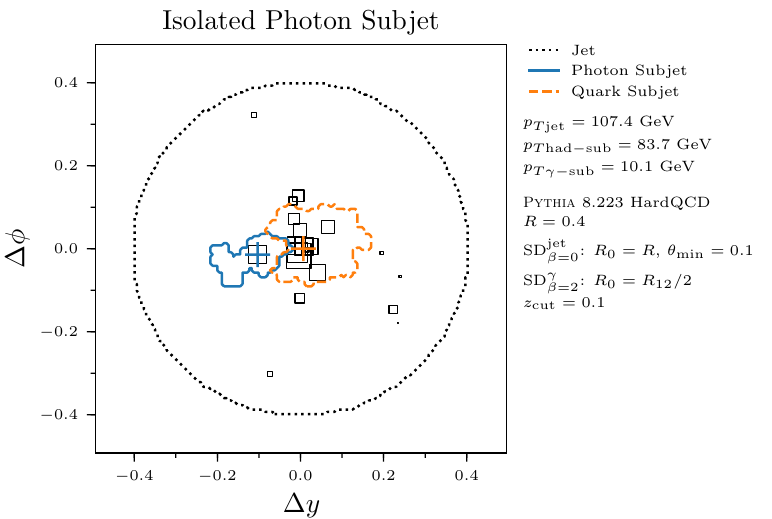
Figure 4. Example jet with an isolated photon subjet from a q q(cid:13) spltting. For the initial ! soft drop, denoted SD jet (equivalent to mMDT [41]), we used parameters z cut = 0 : 1, (cid:12) = 0, and (cid:12) =0 R 0 = R = 0 : 4. For the subjet isolation criterion, denoted SD (cid:13) , we used parameters z cut = 0 : 1, (cid:12) =2 (cid:12) = 2, and R 0 = R 12 = 2, where R 12 is the angle between the two